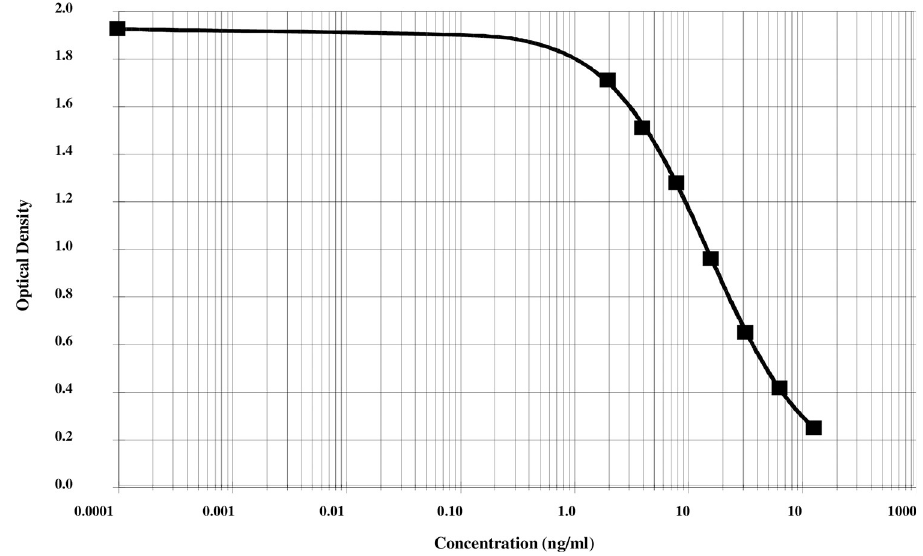
Fig 1. Example of Col3-4 ELISA calibration curve. A log-lin-4-parameter calibration curve is used to analyse the serum Col3-4 assay results. The Col3-4 concentration (ng/ml) of each sample is determined by interpolation from the standard curve. Four parameter logistic equation: y = b+ (a-b)/(1+xc)^d, a = 1,919, b = 0.059, c = 0.081, d = 0.952, R 2 correlation coefficient = 0.999.